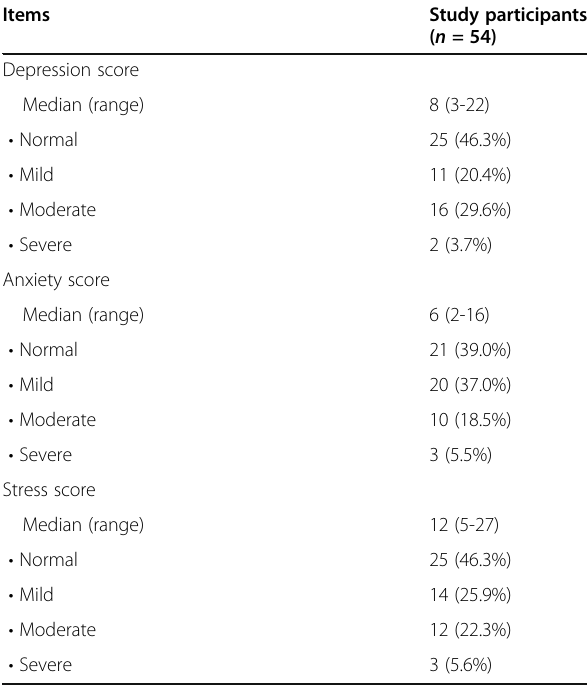
Table 2 The Depression, Anxiety and Stress Scale — 21 Items (DASS-21) of the studied mothers